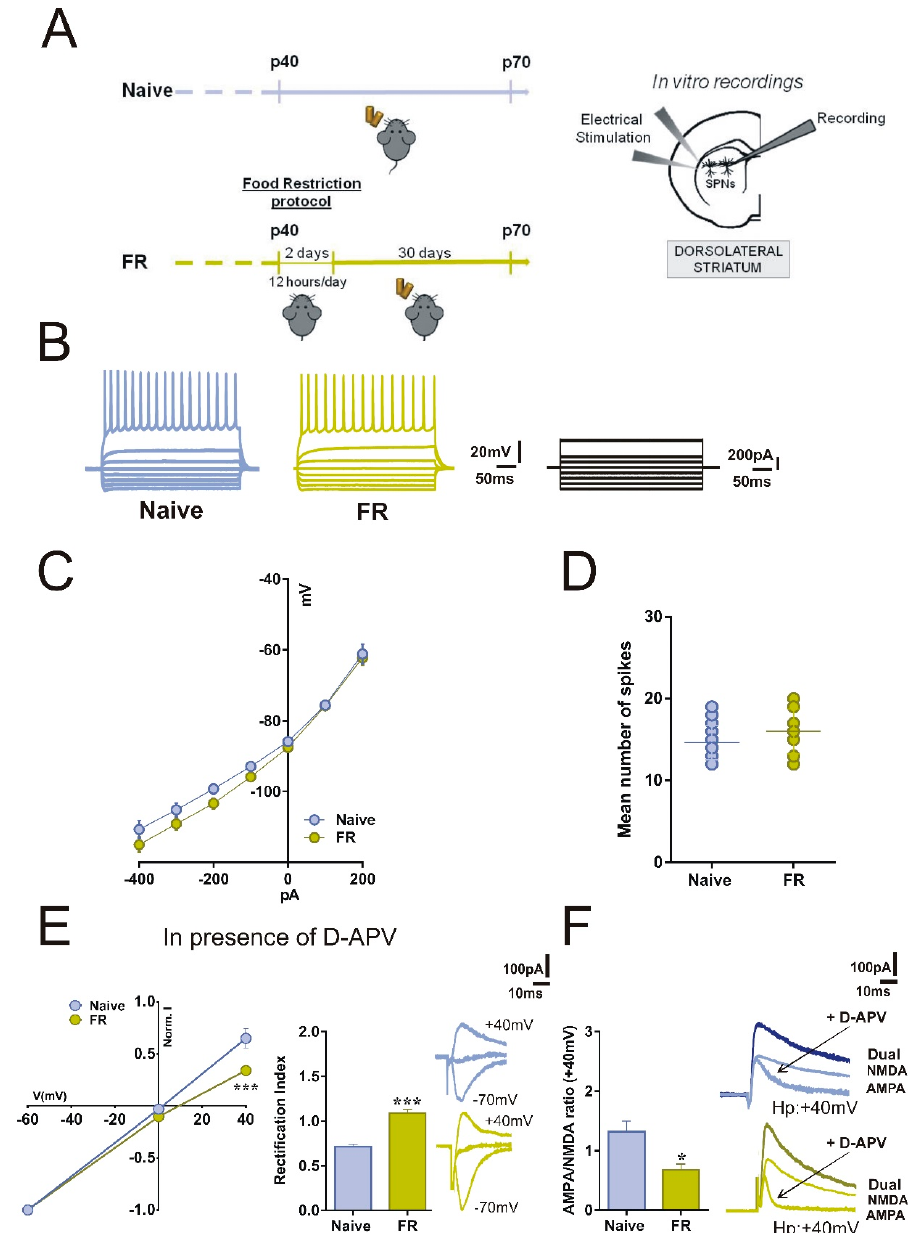
Figure 1. Acute food restriction is associated with changes in glutamatergic transmission in spiny projection neurons (SPNs). ( A ) Experimental plan of Naïve and food-restricted condition. ( B ) Representative firing traces and ( C ) current-voltage (I/V) graphs of Naïve ( n = 17) and FR mice ( n = 15), obtained after applying hyperpolarizing and depolarizing steps of current to SPNs recorded in dorsolateral striatum. ( D ) The aligned dot plot shows the mean number of spikes triggered by a step that generates a maximum response. ( E ) Current/voltage curve and bar graph show the rectification pattern and the rectification index in SPNs of Naïve and FR mice. The α -Ammino-3-idrossi-5-Metil-4-idrossazol-Propionic Acid receptor (AMPAR)- excitatory postsynaptic currents (EPSCs) were pharmacologically isolated by application of the N-Methyl-d-aspartate (NMDAR) antagonist D-(-)-2-Amino-5-phosphonopentanoic acid (D-APV, 50 µ M) (current/voltage curve, two-way ANOVA time x group interaction, Naïve n = 19 vs . FR n = 11, F (2,56) = 5.36, *** p < 0.001; bar graph, unpaired t-test, Naïve n = 13 vs . FR n = 15, t = 7.942, df = 28, *** p < 0.001). Example traces of evoked AMPAR-EPSCs recorded at -70, 0, and+40 mV. Scale bar: 100 ms, 100 pA. ( F ) Group mean AMPA:NMDA ratio calculated in Naïve and FR SPNs in the presence of D-APV (unpaired t-test, Naïve n = 10, vs . FR n = 8, t = 2.911, df = 16, * p < 0.05); example traces of evoked AMPA- and NMDA-EPSCs at +40 mV (Dual: AMPA + NMDA EPSCs; NMDA EPSCs: obtained by subtraction of the EPSCs measured before and after the application of 50 µ M D-APV; AMPA EPSCs: isolated by application of 50 µ M D-APV). Scale bar: 100 ms, 100